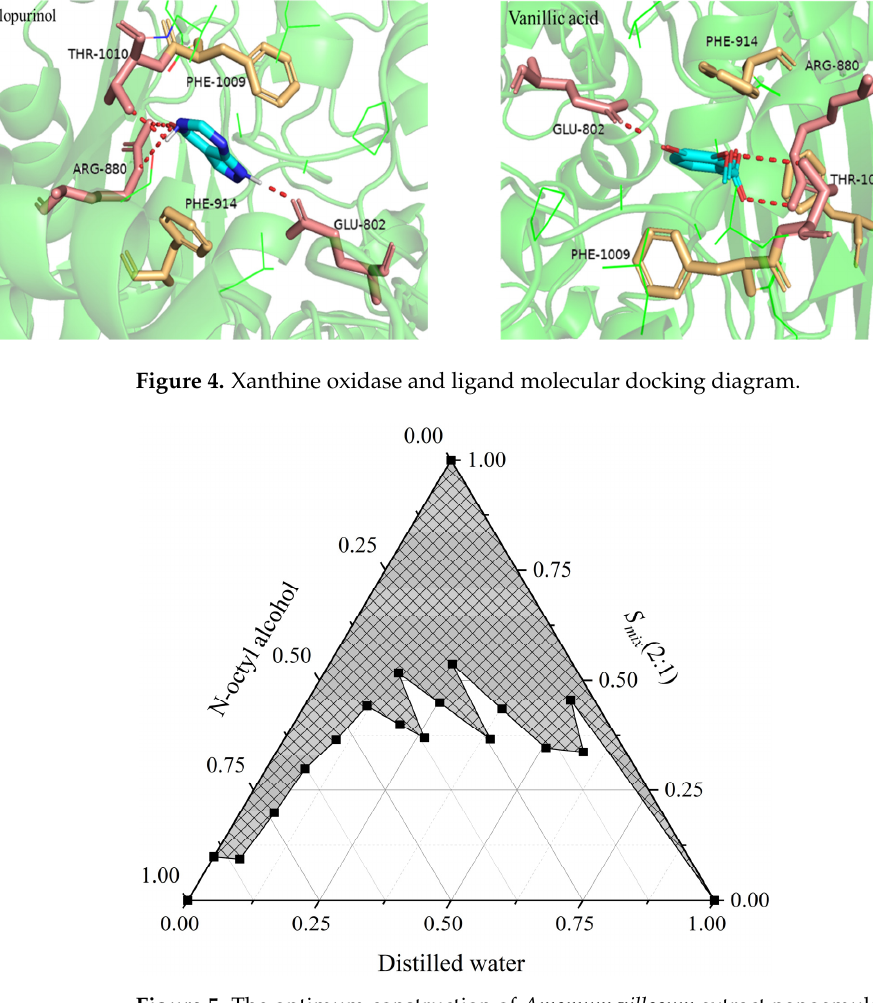
Figure 5. The optimum construction of Amomum villosum extract nanoemulsion containing water, oil, Tween 80%, and 95% ethanol, with 2:1 ratio.